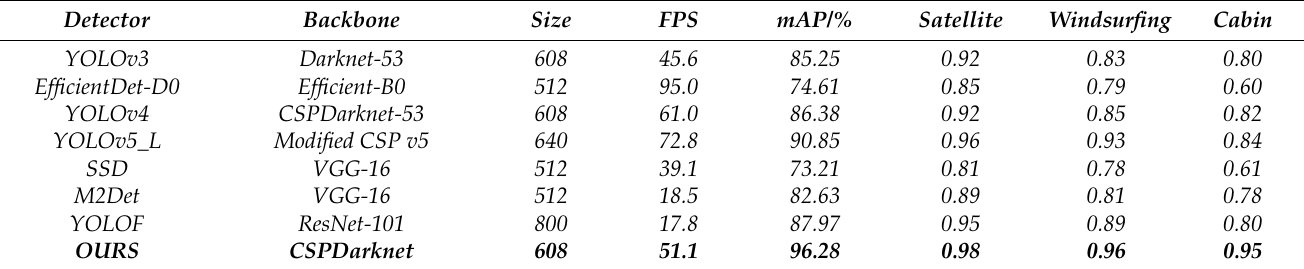
Table 7. Effectiveness of our improvement